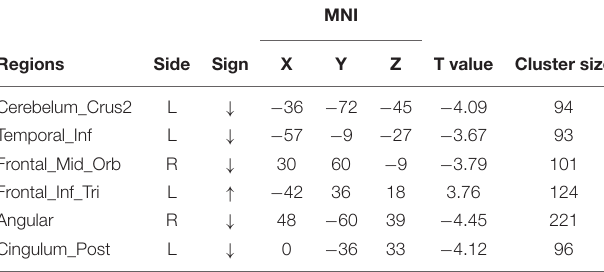
TABLE 6 | Between-group comparisons of mPFC rsFC